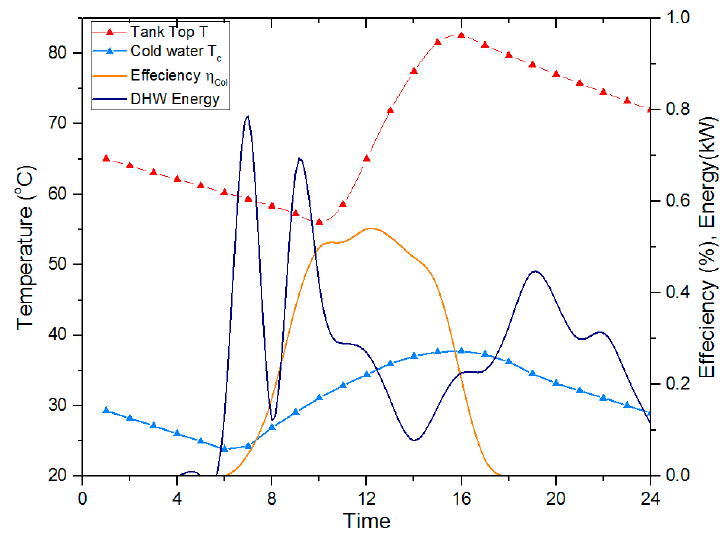
Figure 7. Dynamics of solar hot water system (SDHW).